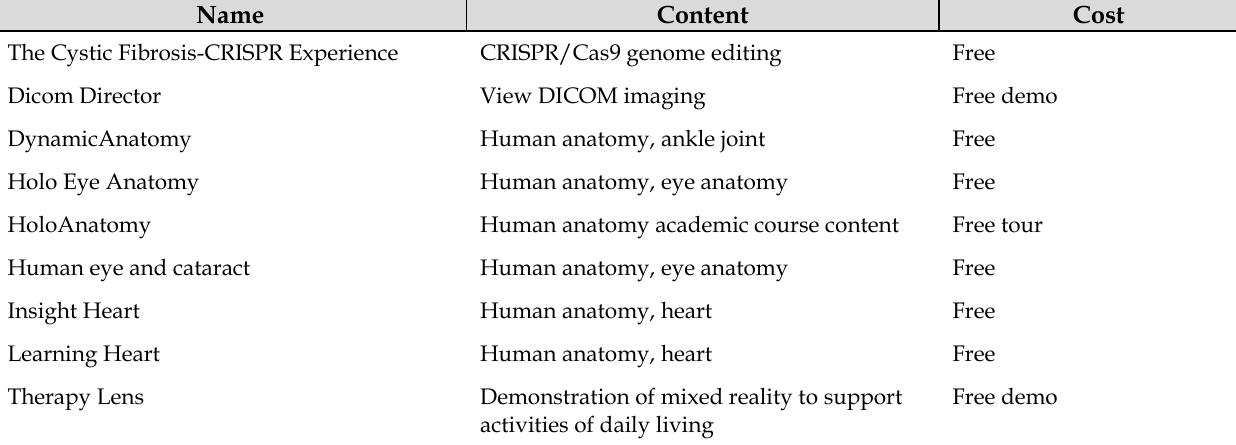
Table 2 Anatomy and health sciences–related applications for the Microsoft HoloLens